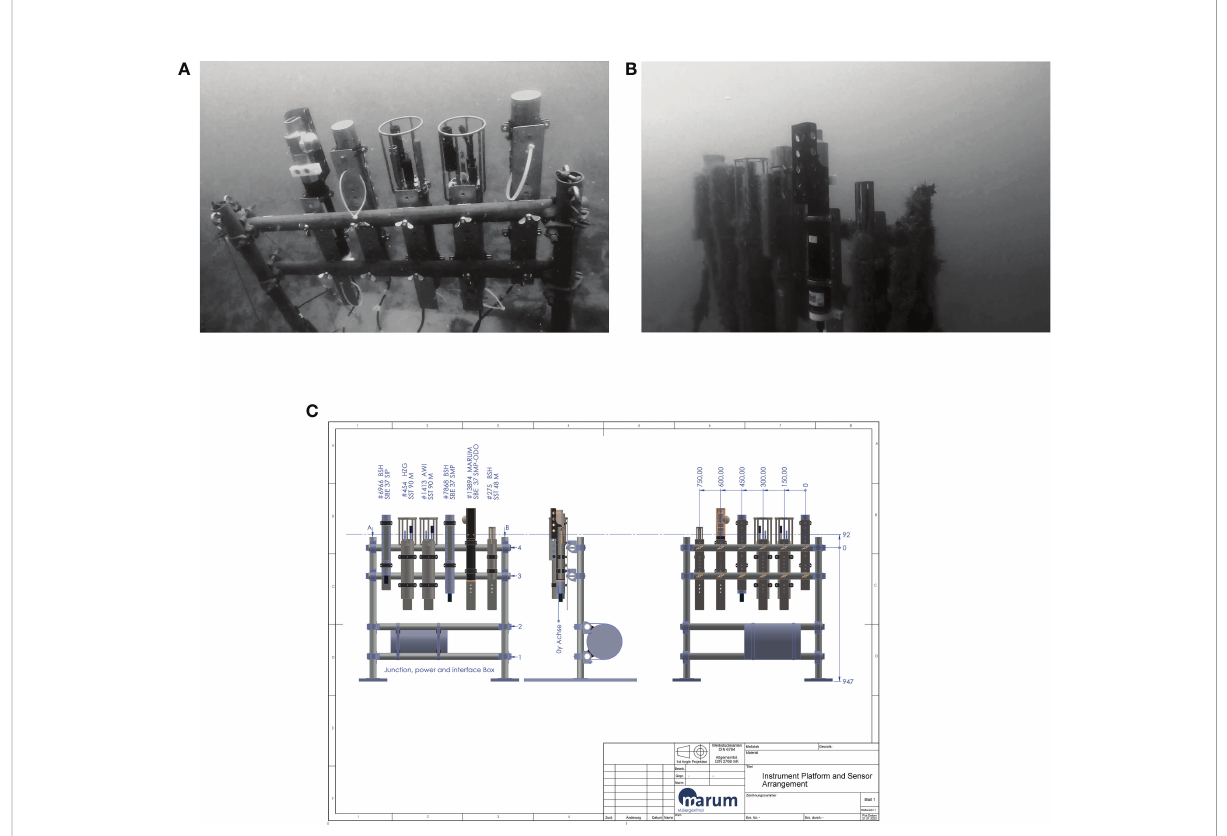
FIGURE 1 In situ images (upper panels A and B ) and CAD drawing (lower panel C ) with dimensions of the experimental setup of the deployed sensors. Upper left panel: Sensors immediately after deployment, Upper right panel: Sensors three month after deployment with one sensor (second from the right side) freshly lab-calibrated and maintained. For details see